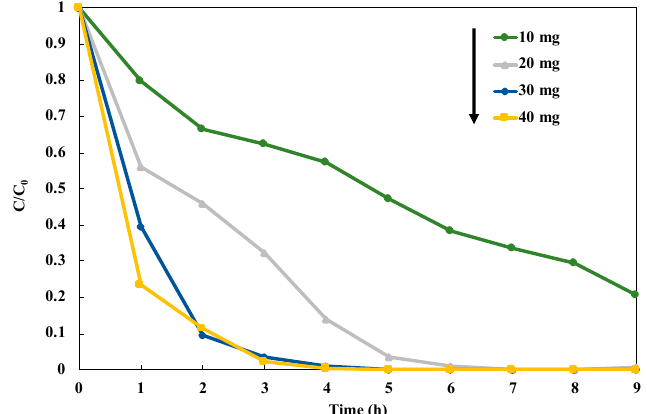
Figure 9. Influence of loading catalyst amount on NO 3 − reduction in 45 mL of 50 ppm NO 3 − aqueous solution including 10 vol% CH 3 OH under UV irradiation for nine hours.